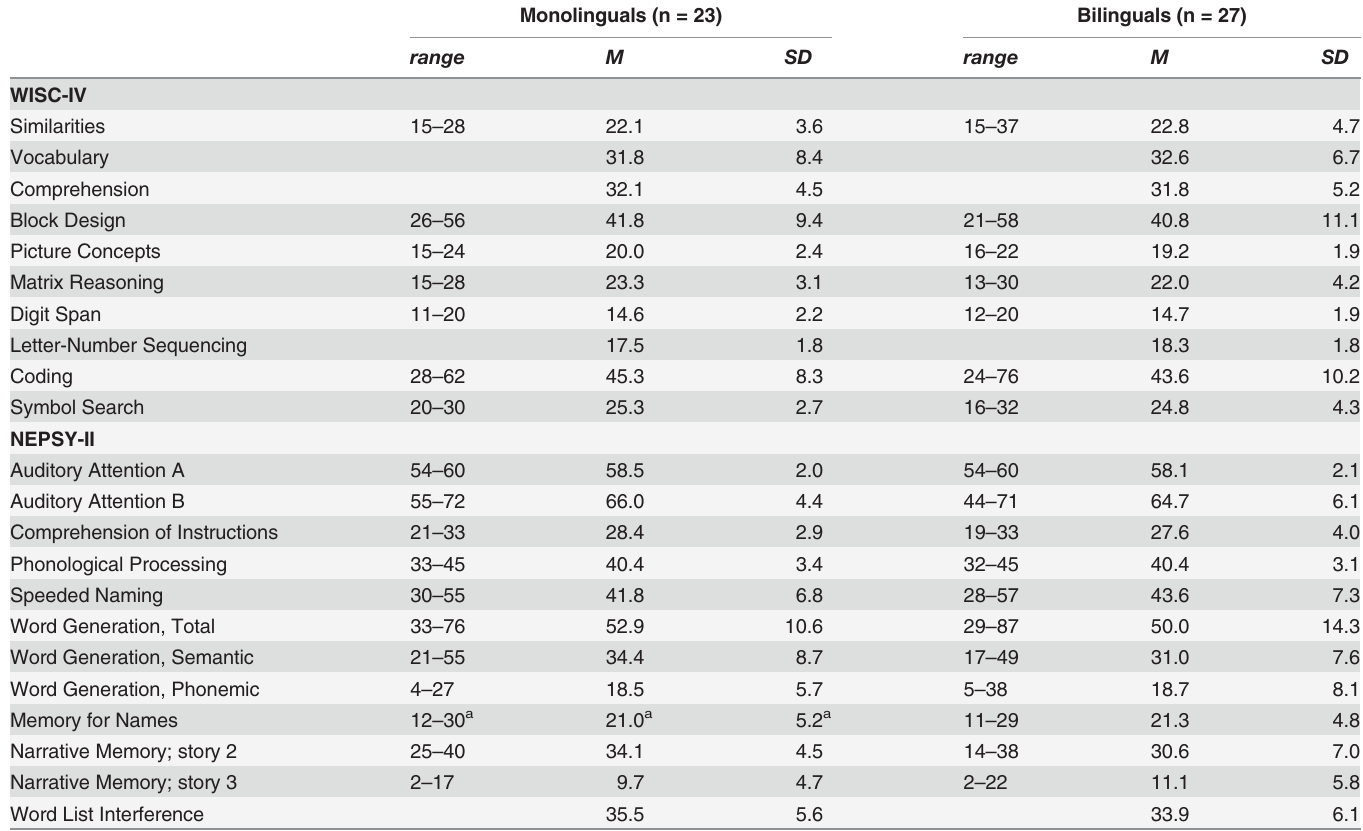
Table 5. Test Performance in Raw Scores of Monolinguals and Bilinguals in the older